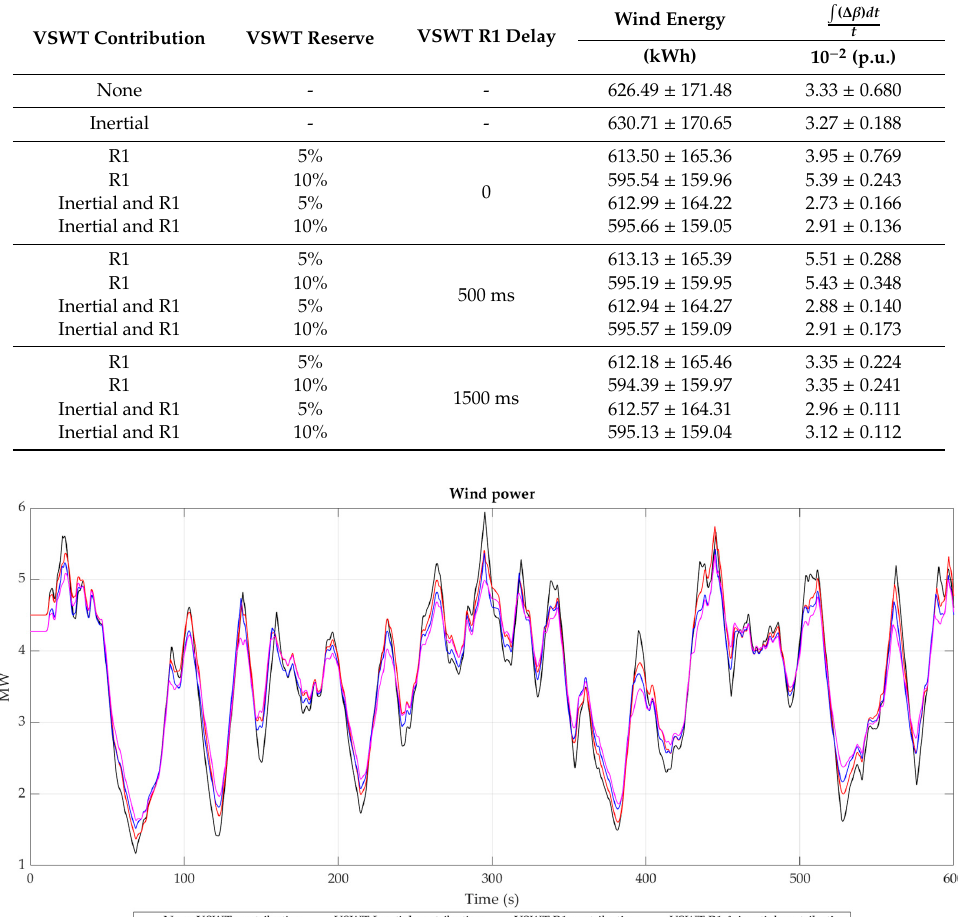
Table 5. Average values of VSWT parameters considering the proposed VSWT contributions.